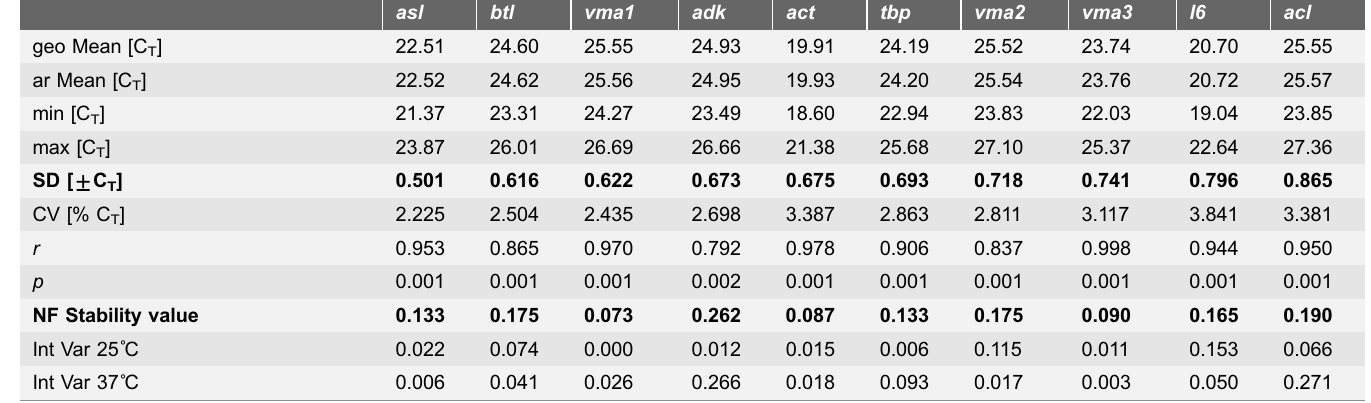
Table 4. Descriptive statistics and stability values of candidate reference genes under temperature fluctuations (n 5 12). asl btl vma1